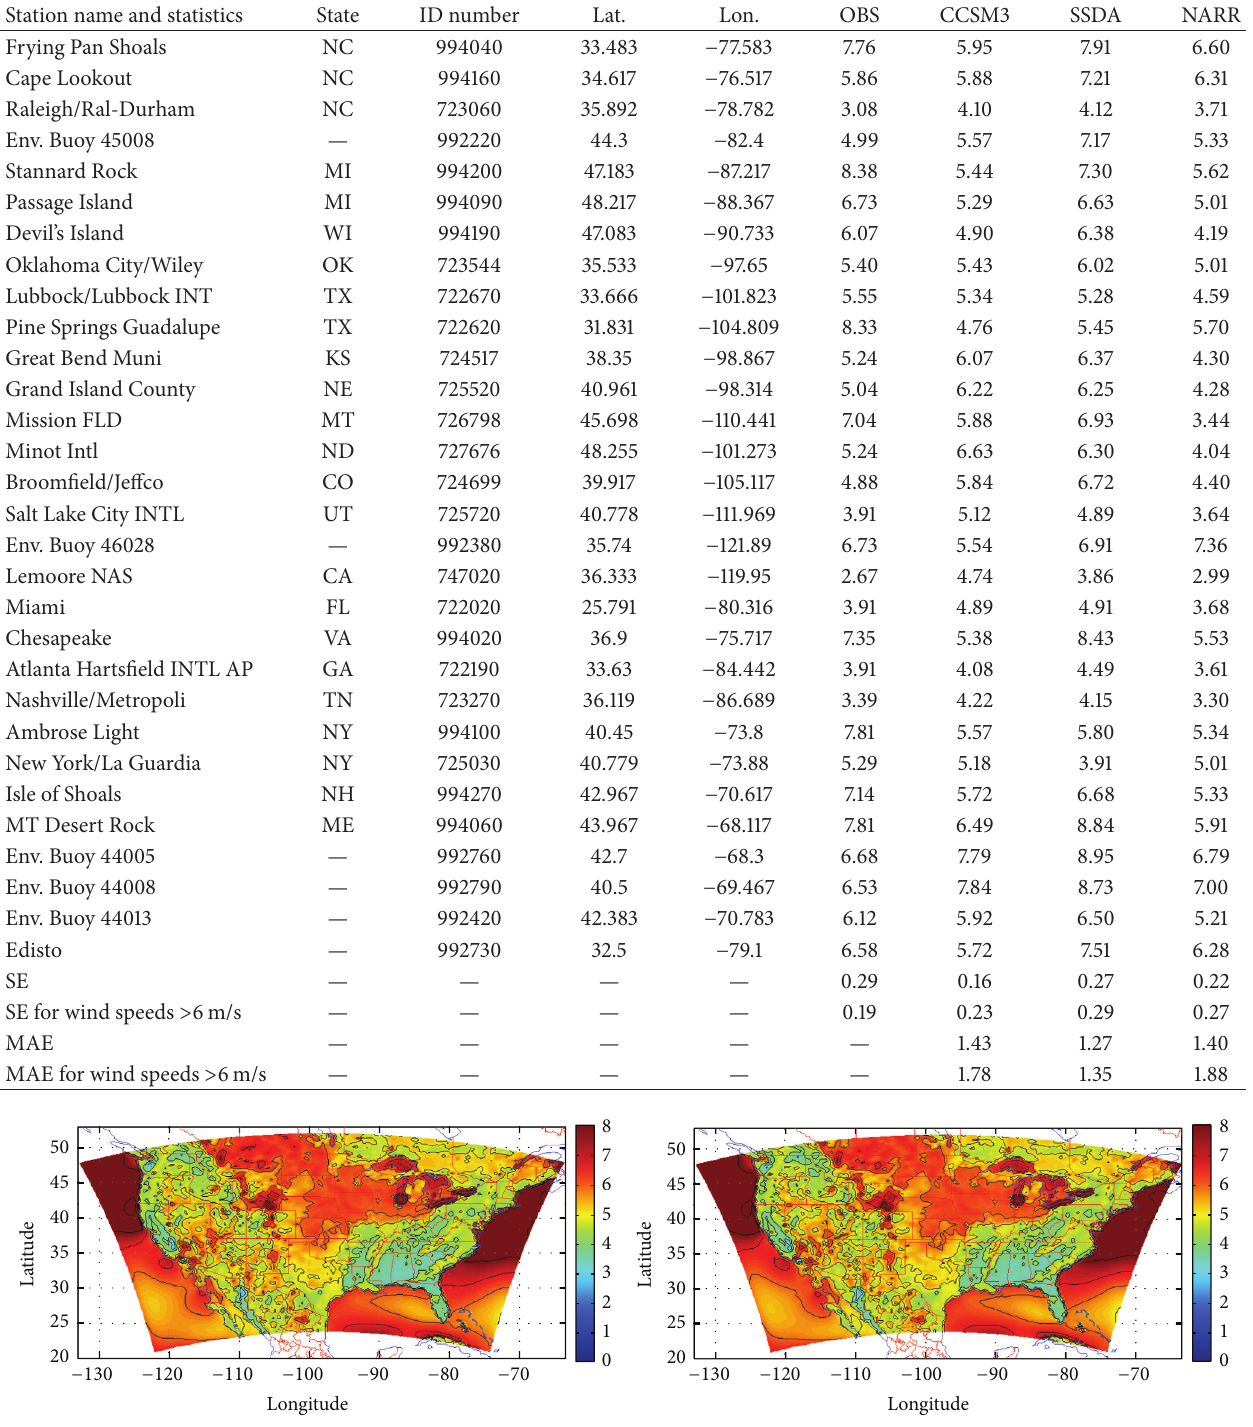
Table 2: Annual mean wind speed comparison of SSDA downscaled CCSM3 data, CCSM3 raw data, and NARR data to station observations for current climate (1990–1999). Also, the standard error (SE) is shown for the observations, CCSM3, SSDA, and NARR data sets for all 30 stations as well as the 15 selected stations with wind speeds > 6ms − 1 . Mean absolute error (MAE) for average annual wind speed for current climate (1990–1999) between raw CCSM3 data, SSDA data, and NARR data all compared to the station data. Also, the MAE for average annual wind speed greater than 6 ms − 1 is calculated.